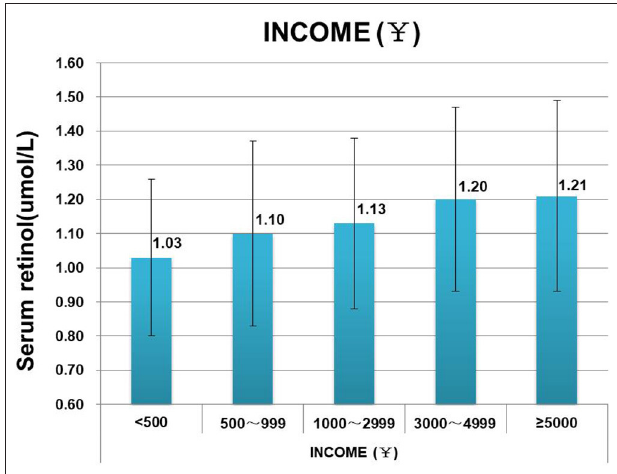
FIGURE 4 | Comparison of vitamin A levels of children from households of different income.